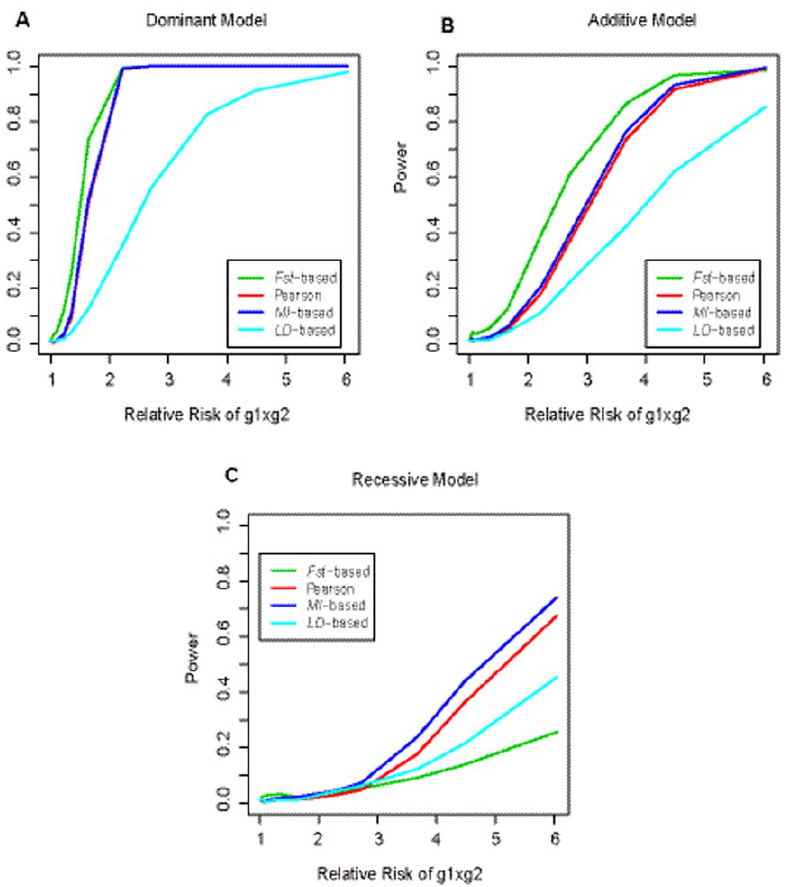
Figure 5. Power of four statistics under three different model when the disease allele frequencies at the two loci are low. The disease prevalence is assumed to be 1%. The disease allele frequencies at the two loci are 0.2 and 0.4, respectively. The power, at significance level a of 0.05, is obtained based on simulations of 500 cases and 500 controls. The green, red, blue, and cyan lines are the power of Fst based statistic, Pearson’s Chi- square statistic, MI based statistic, and LD based statistic, respectively. Three plots (A, B, C) correspond to the dominant model, the additive model and the recessive model, respectively.